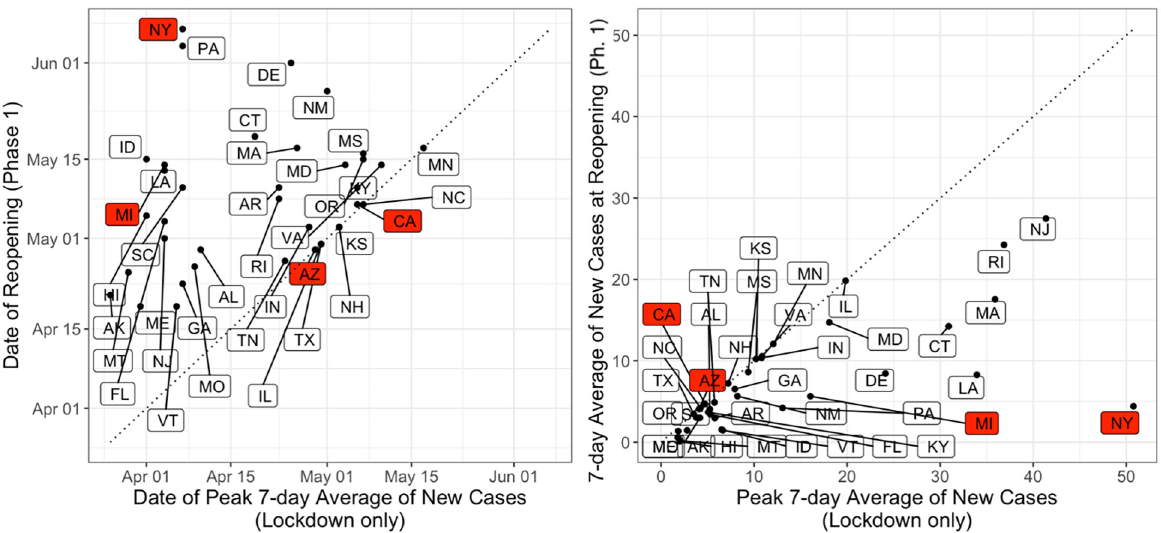
COVID-19 incidence per 100,000 people at reopening to Phase 1 as a function of peak 7-day average of COVID-19 incidence per 100,000 during the state lockdown, for the states examined.